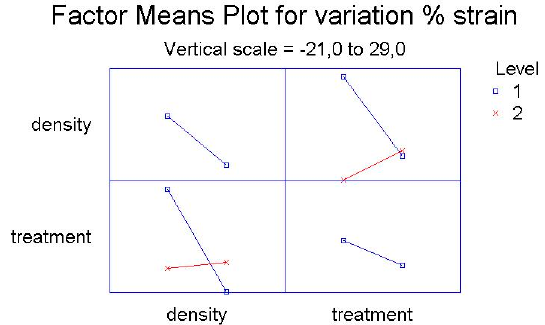
Figure 5. Factors Means Plot for percentage variation of strain.